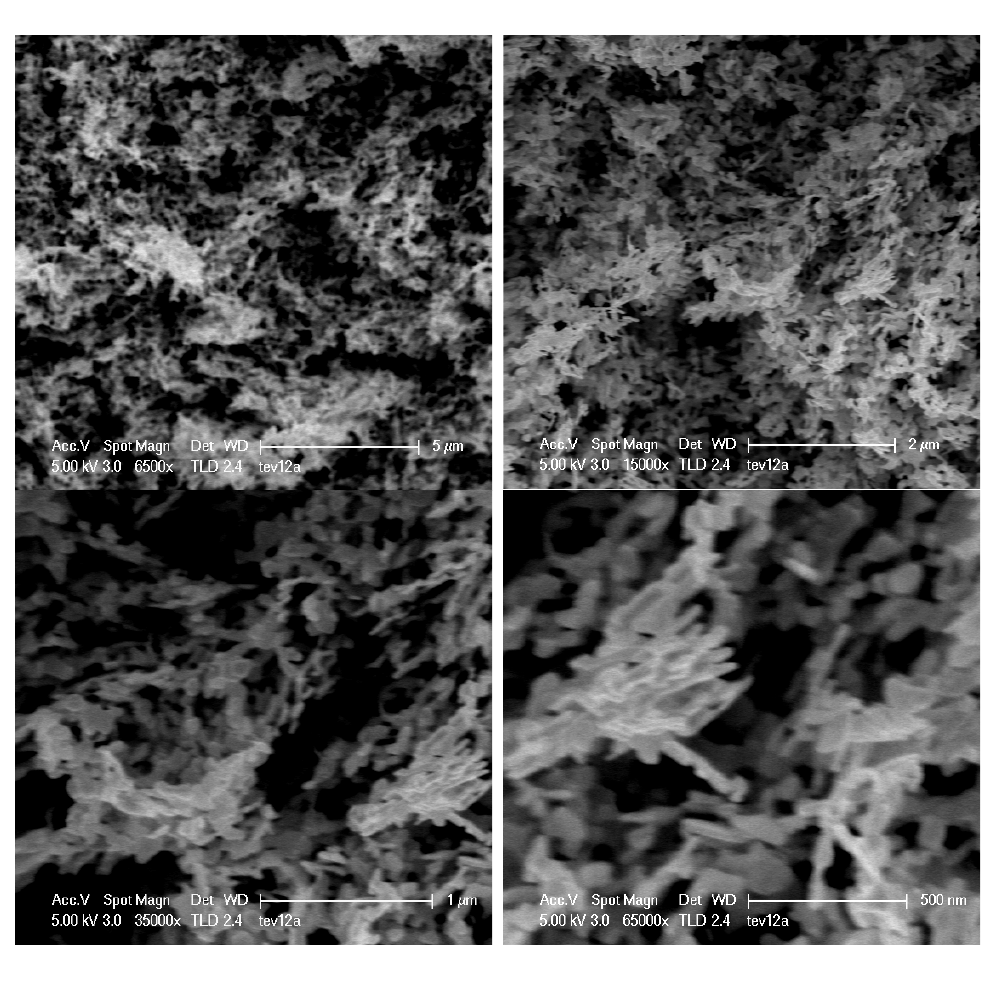
Fig. 4 SEM micrographs of sample Mn 3 O 4 at different